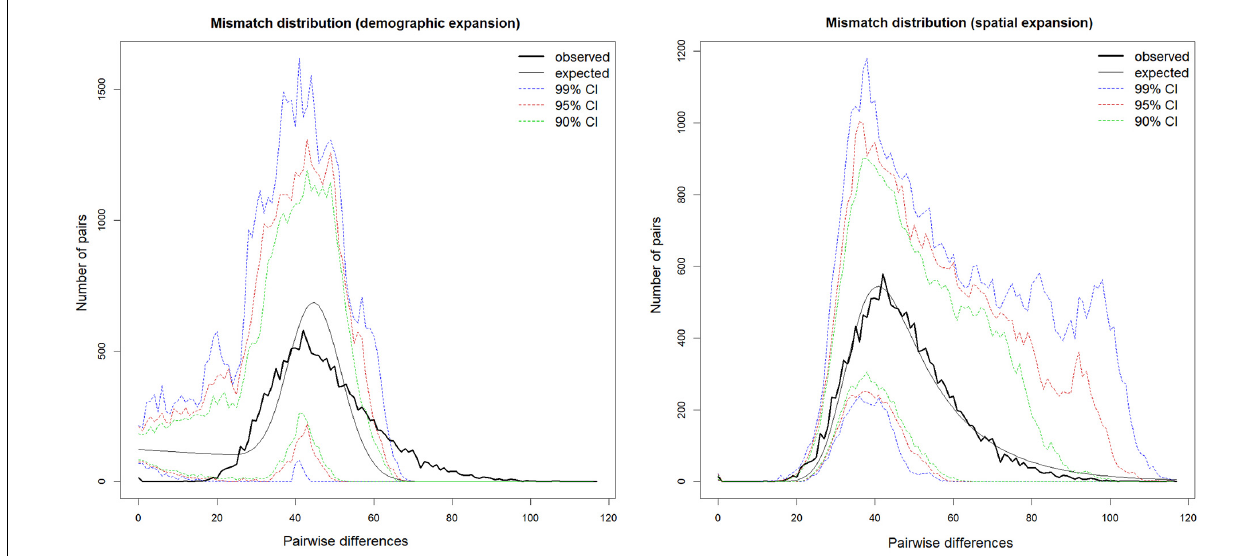
FIGURE 3 | Mismatch distributions of Aphis aurantii based on the concatenated cox1 and cytb sequences.